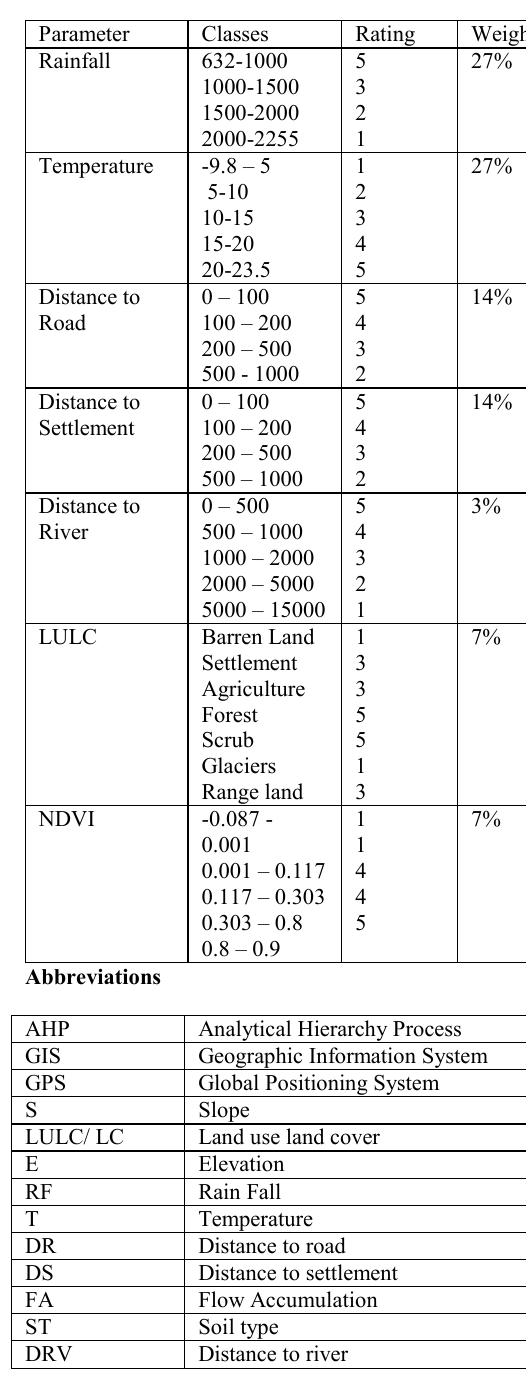
Table 11 Classes of the parameters and according weights for Forest Fire Vulnerability